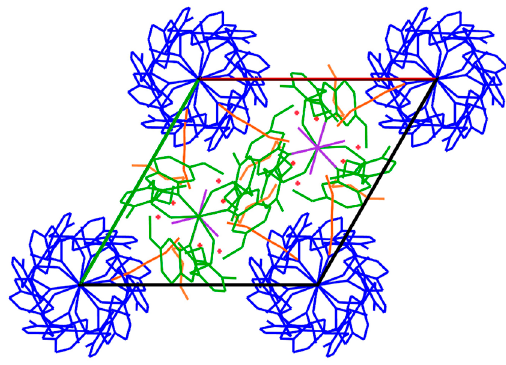
Figure 3. Esomeprazole magnesium molecules crystalize in P6 3 spaces group alongside with water and 1-butanol molecules; the molecules of the same color are symmetry equivalent.